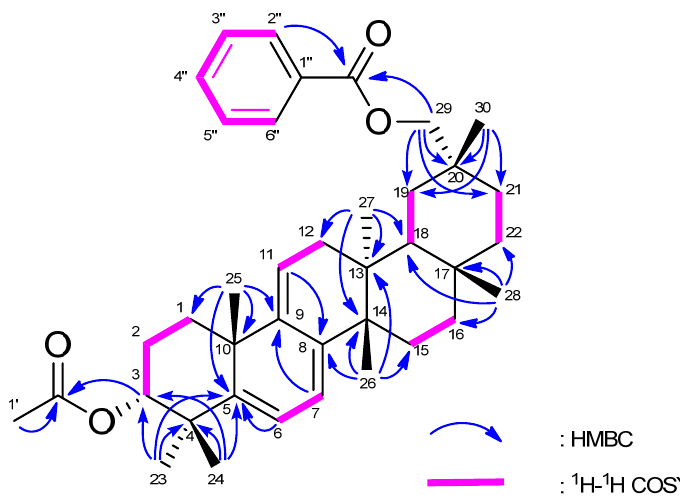
Figure 5. Selected 1 H- 1 H COSY and HMBC correlations for 3 .